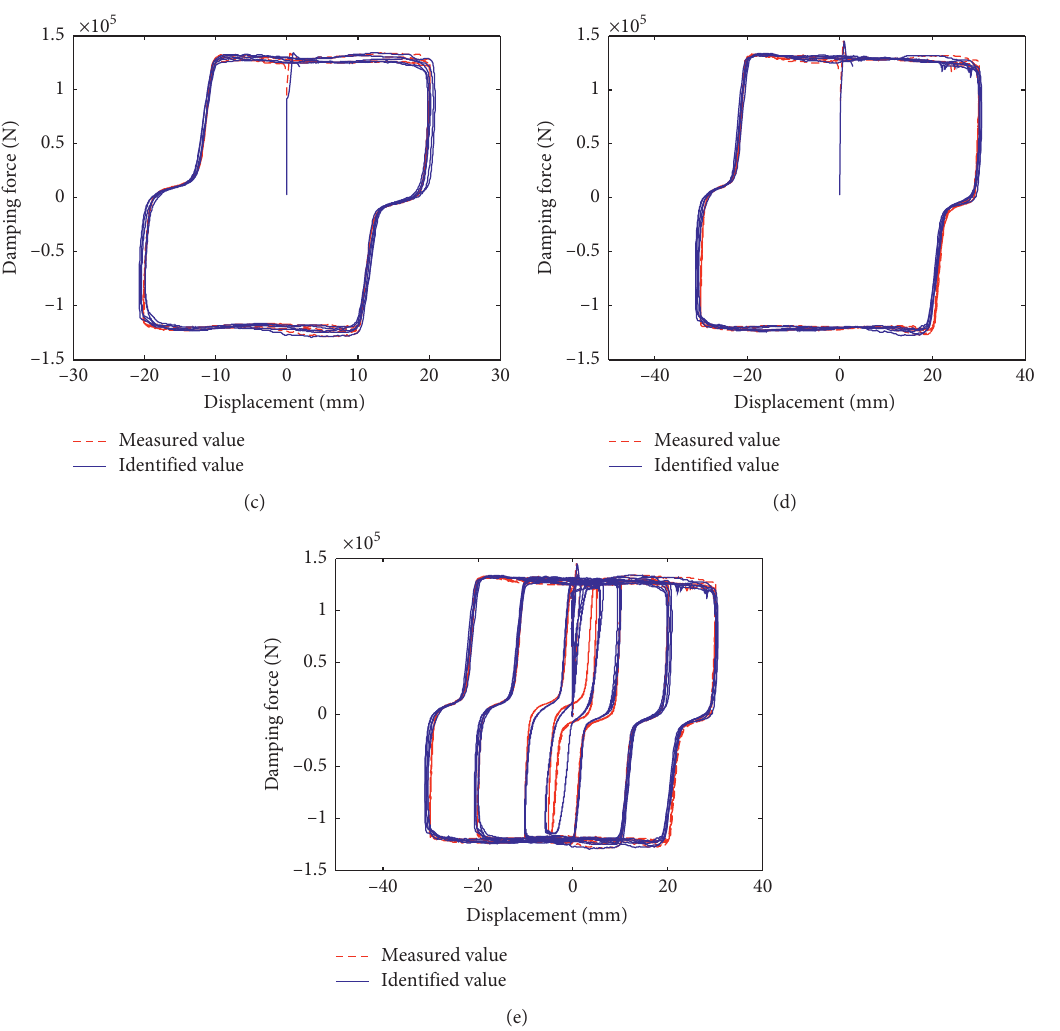
Figure 8: Comparison between identified values and measured values. (a) A General damping force vs displacement